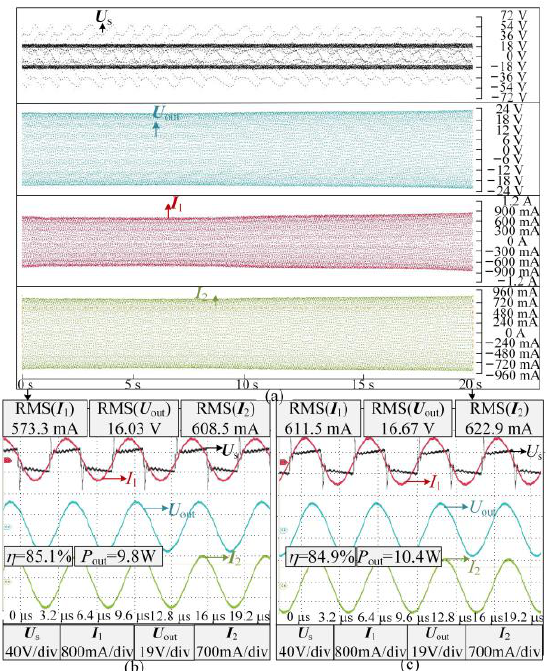
Figure 11. Experimental waveforms of U s , I 1 , I 2 and U out after compensation. Continuous waveform: ( a ) 0.1-m offset in the Y -axis occurs first and then 0.1-m offset in the X -axis occurs. Stationary waveform: ( b ) well-aligned; ( c ) 0.1-m offset in the X -axis and Y -axis occurs simultaneously.